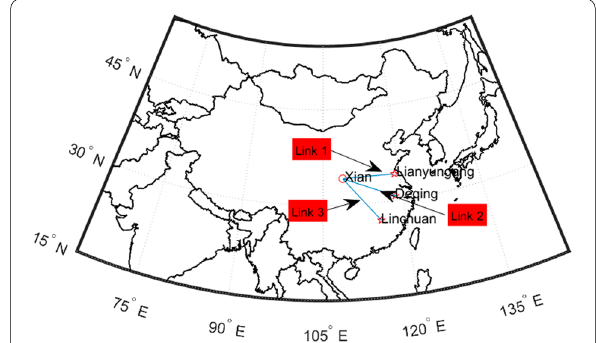
Fig. 2 Map showing positions of the radio paths used in the experiments; the geomagnetic azimuth of the three paths are 90.1°,112.5°and 141.6°, respectively